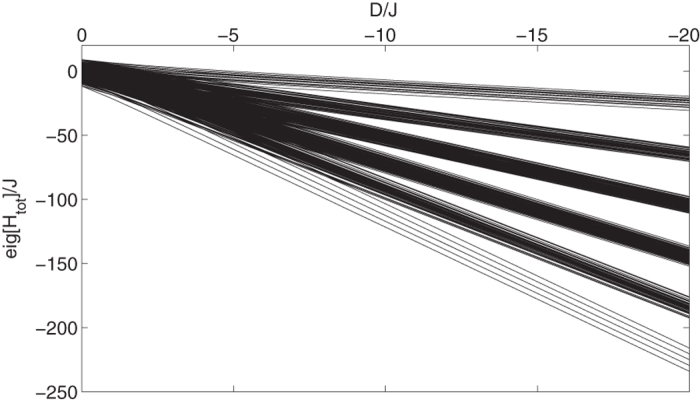
Emergence of energy bands.Energy spectrum of Htot for N = 5, , and E = 0, as a function of D/J. When |D| ≫ J a band structure appears in the spectrum. The lowest energy band (composed by the 2N levels in the subspace ) forms the memory subspace, while the highest energy band (composed by the 2N levels in the subspace ) forms the data-bus subspace.